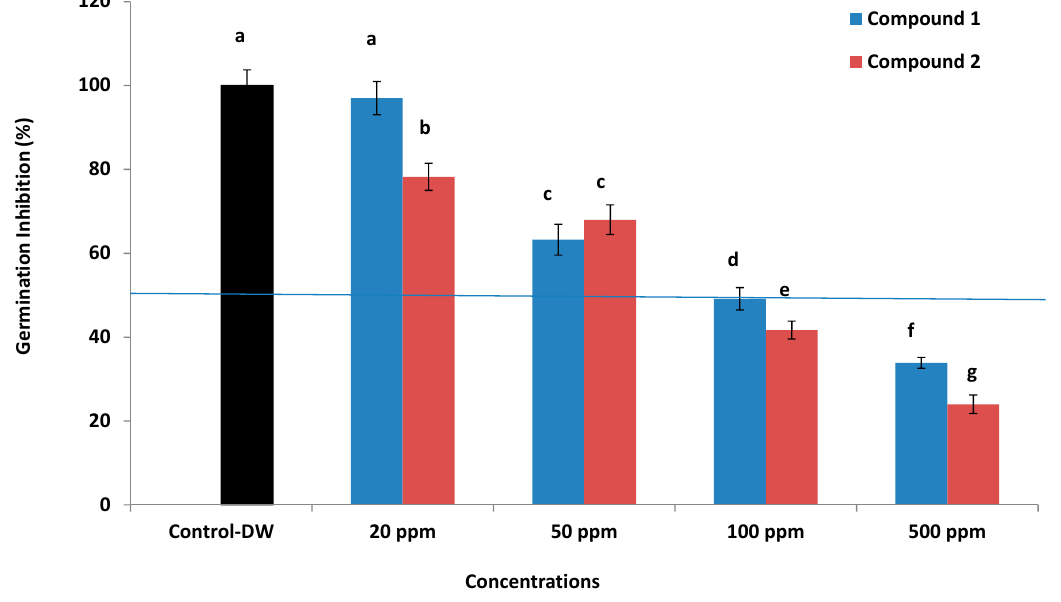
Figure 3. Allelopathic effects of compound 1 and 2 on the growth of lettuce seeds and pathogenic fungi; the bars represent the mean values with standard error of three replications. The different letter (a, b,...g) on each bar shows significantly ( p < 0.05) different values as evaluated by DMRT analysis.